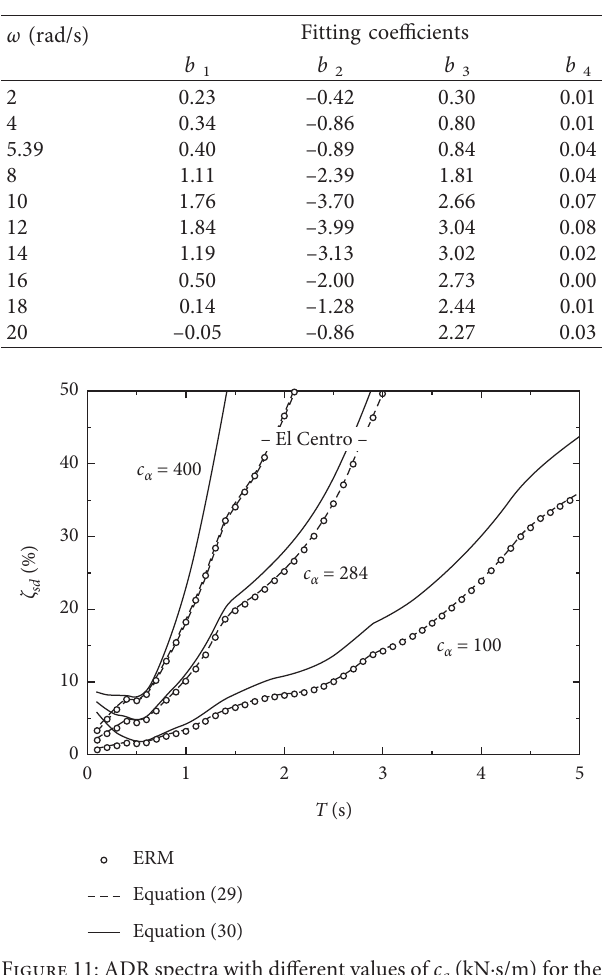
· s/m) for the a (kN